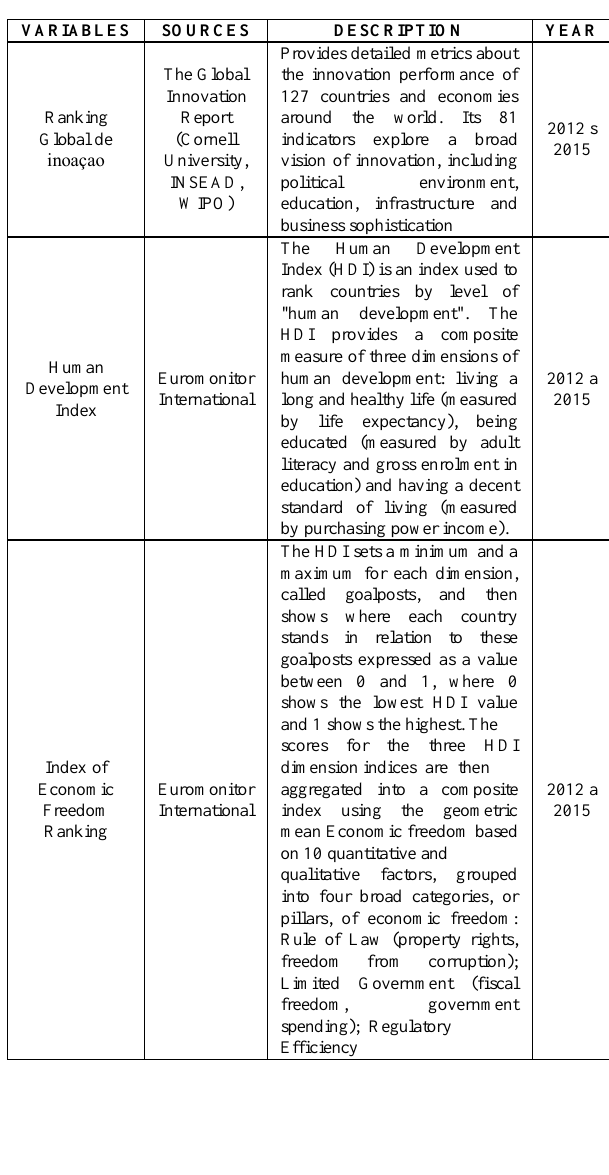
Figueira. Patentes, pesquisa e desenvolvimento: um manual de propriedade intelectual. Rio de Janeiro: FIOCRUZ.